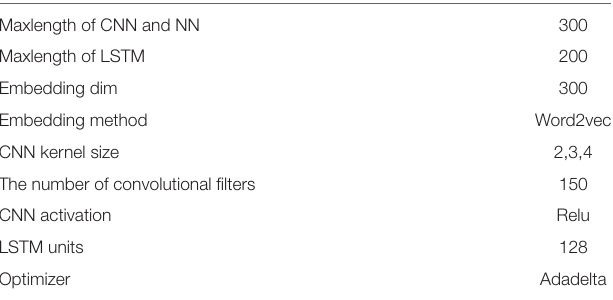
TABLE 2 | The parameter